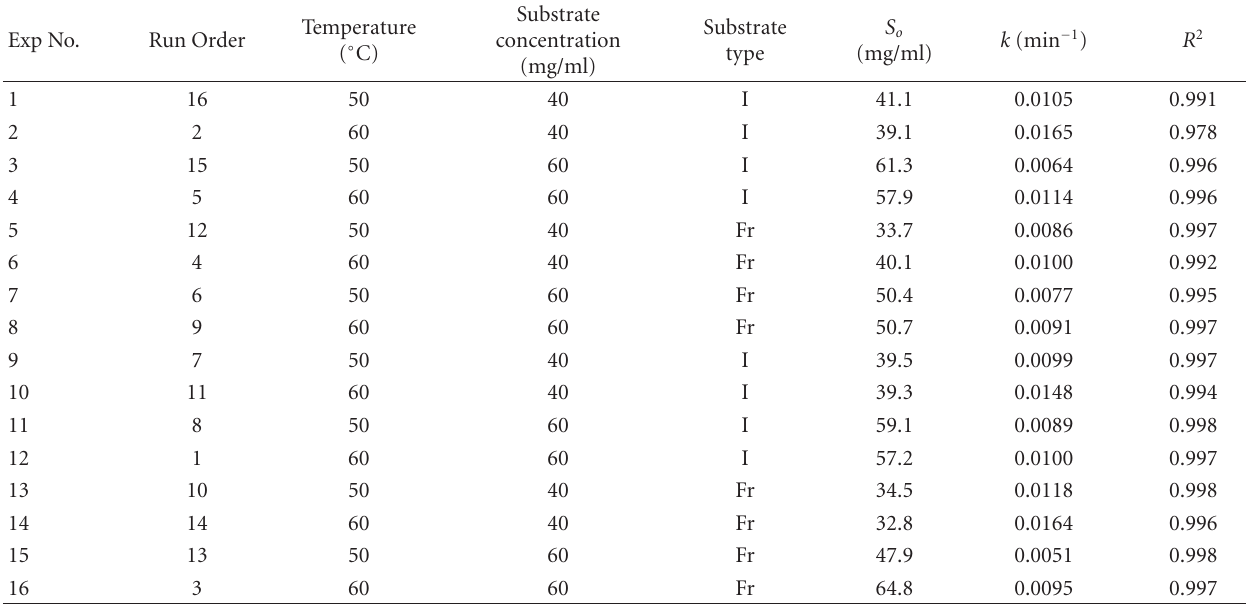
Table 1: Values of the rate constants ( k ) and their respective R 2 determined through regression method for each experimental condition. Exp No. Run